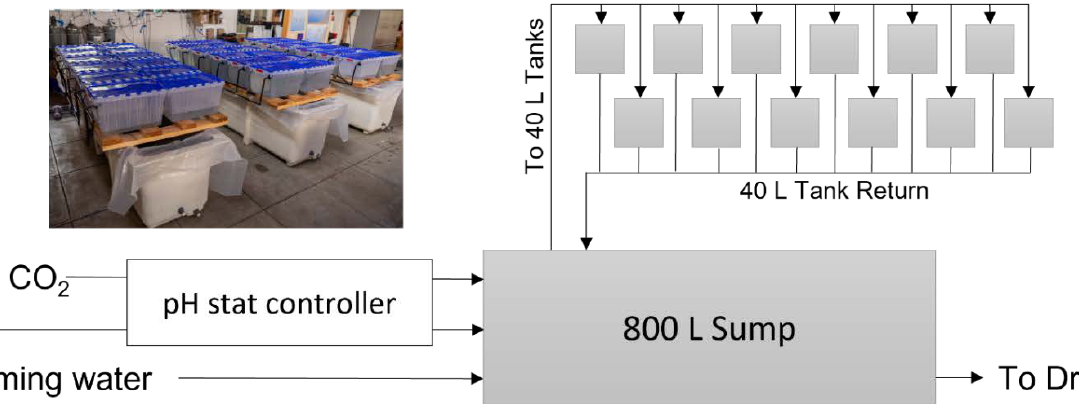
Figure 1. Schematic diagram of one of the three identical pCO 2 control systems used in the experiment. Fresh spring water flowed continuously through the main sump and recirculated amongst the experimental tanks. A pH stat controller added either pure CO 2 or ambient air as required to maintain water pH within the target range. The image in the top left shows arrangement of all three pCO 2 treatment systems in the laboratory.